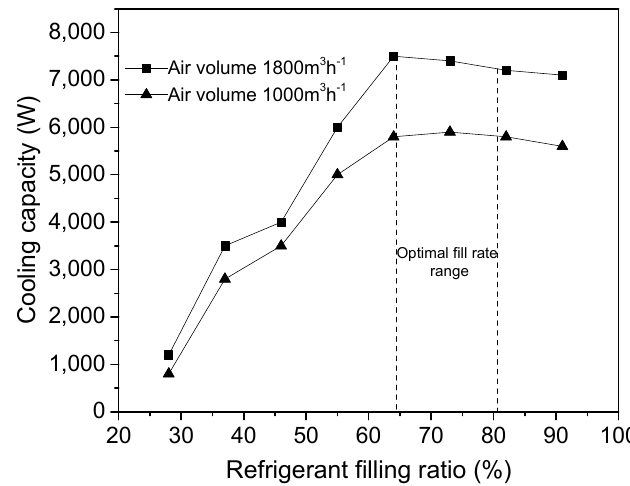
Figure 6. Relationship between cooling capacity and refrigerant filling rate under different air volume flow rate conditions.